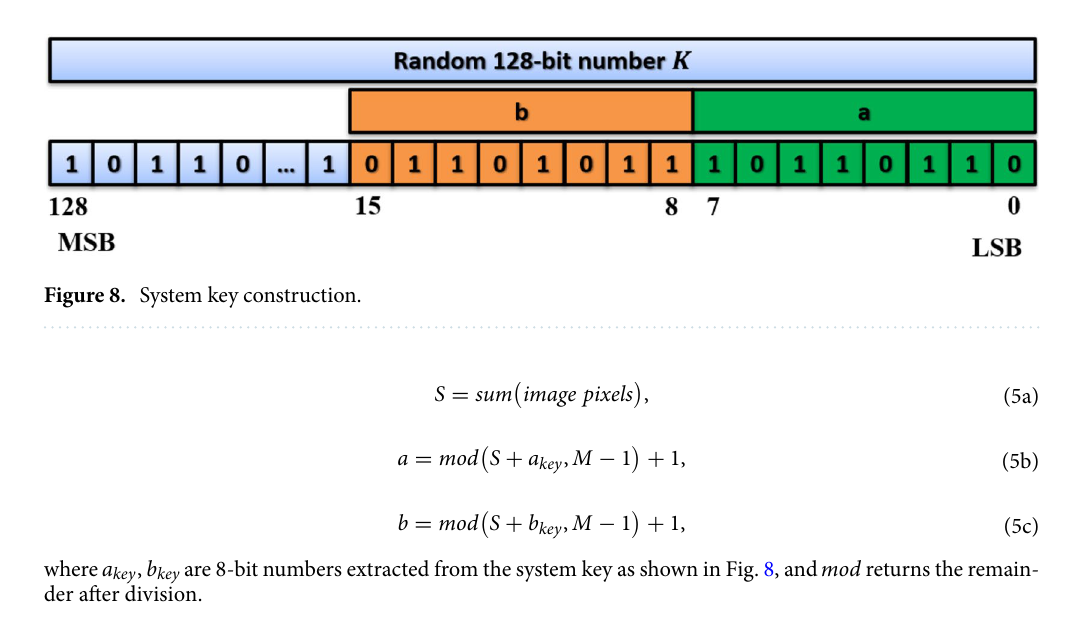
Figure 7. Block diagram for ( a ) the encryption system and ( b ) the decryption system.